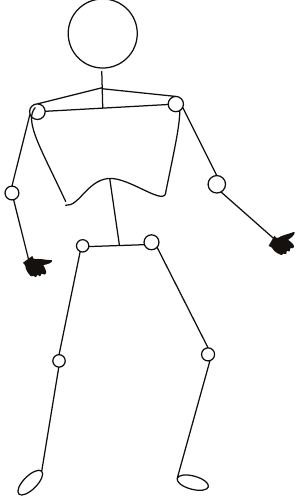
Figure 3: An illustration of the many degrees of freedom for articulation in a human